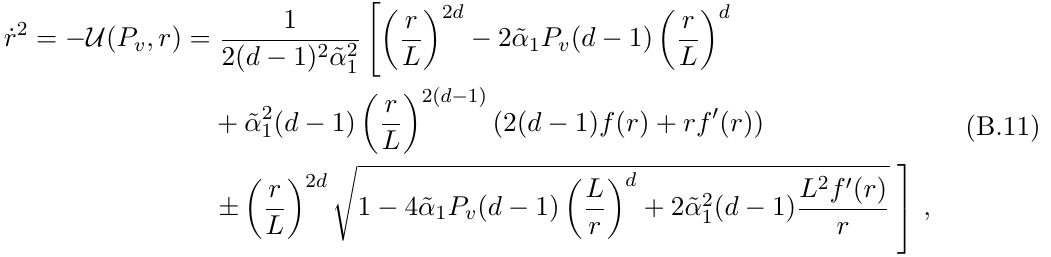
. The solid/dashed curves denote the positive/negative v = 1 , d = 3 for this plot. h /L